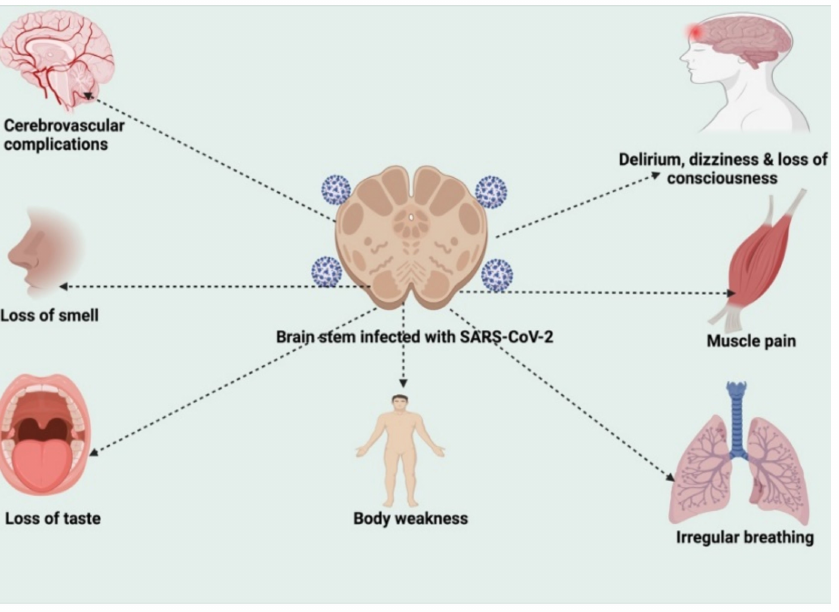
Figure 1. Some neurological signs of COVID-19